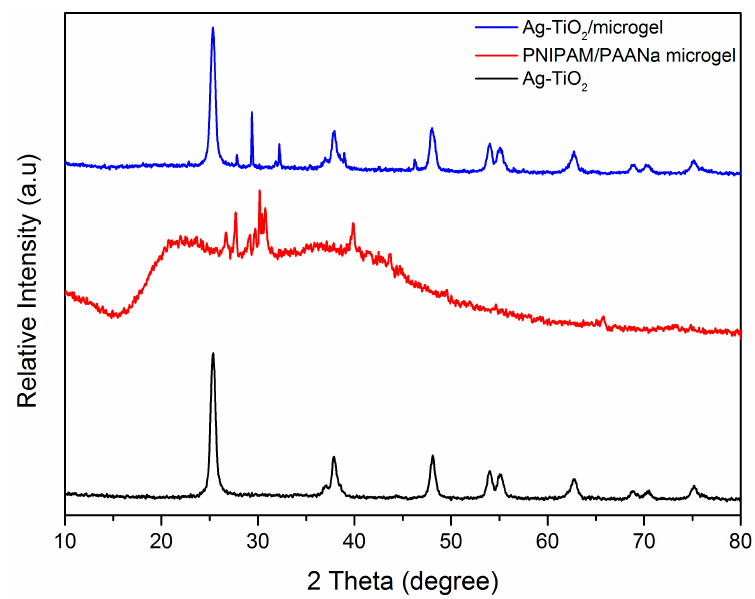
Figure 4. XRD patterns of Ag-TiO 2 nanoparticles (in black), PNIPAM/PAA salt (in red) and PNIPAM/PAA microgel/Ag-TiO 2 (in blue).